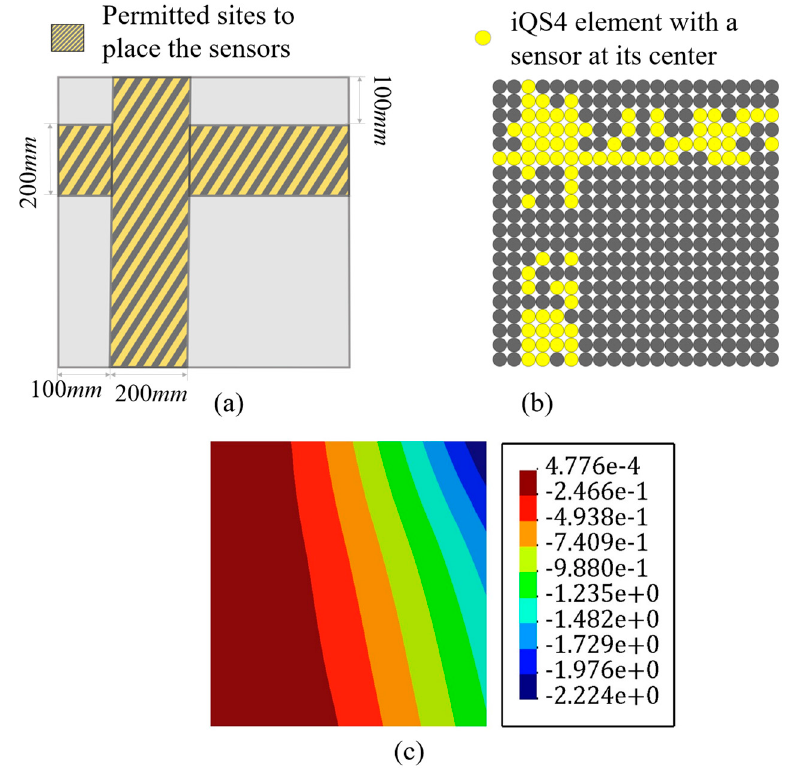
Figure 13. The iFEM-GA results of the plate depicted in Figure 10 with limited search space. ( a ) The permitted sites to place sensors, ( b ) optimum sensor placement, and ( c ) displacement contours.